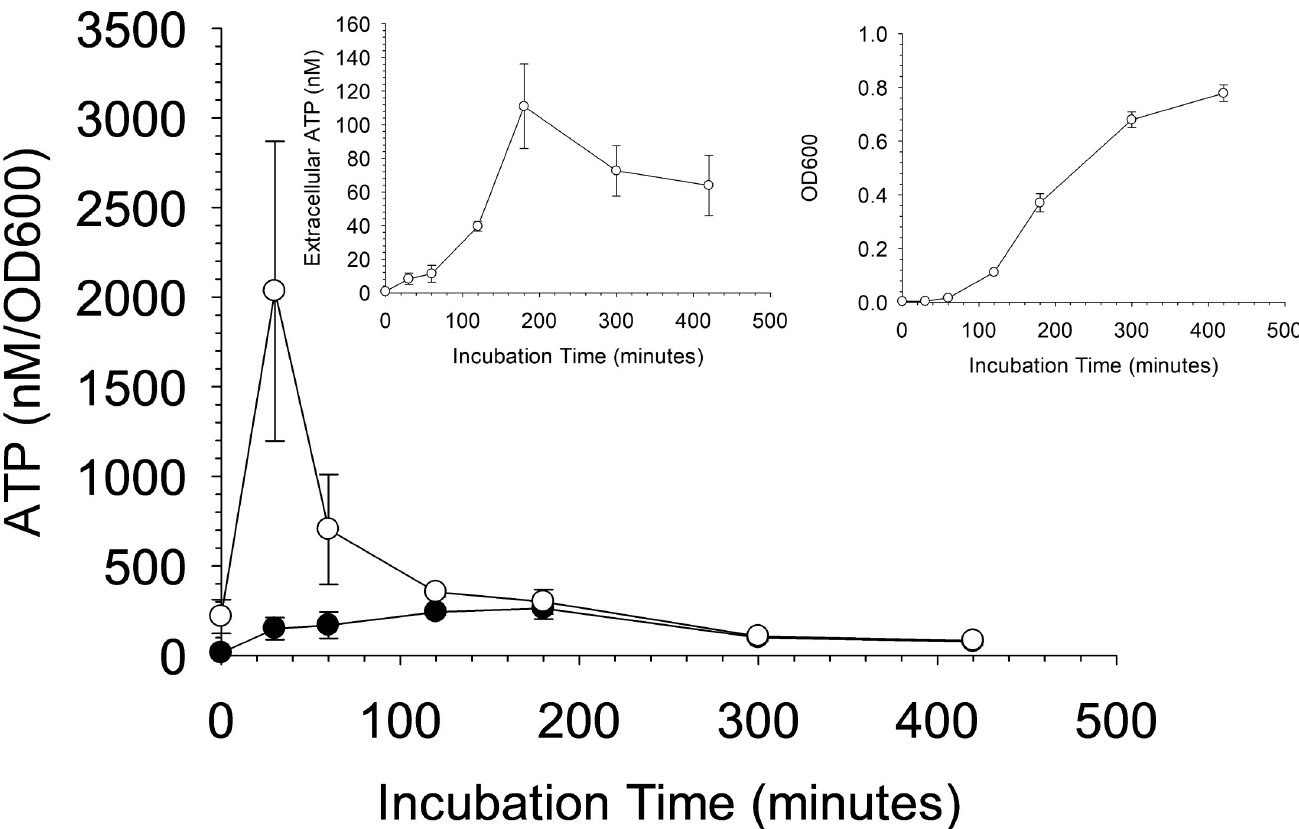
Fig 2. Evaluation of the extracellular ATP and optical density during growth of E . coli . ATP/OD600 curve for gram-negative E . coli with (open circles) and without (dark circles) the background absorbance caused by the 96 well plate and growth media. Inlayed graphs show the individual extracellular ATP (left inlay) and OD600 (right inlay) curves. The OD600 curve does not contain the background absorbance. n = 3; error = standard deviation. Note the shift in the peak ATP: OD600 maximum value for the measurements that include the background subtraction.